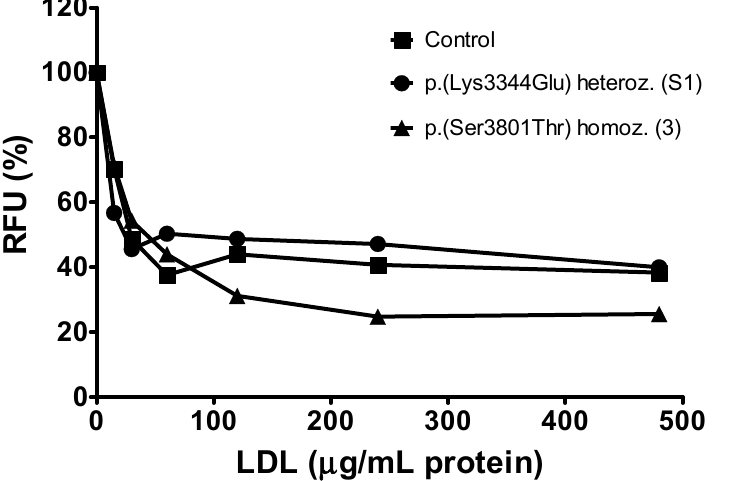
Figure 4. Competitive uptake of LDL by THP-1 macrophages. Ability of LDL from apoB p.(Lys3344Glu) heterozygous patient S1, the apoB p.(Ser3801Thr) homozygous patient 3 and the control to compete with DiI-LDL for cellular uptake ( p = 0.420). Results are expressed as percentage of DiI-LDL uptake in the absence of competitor LDL. The identification of each patient is indicated in brackets (see Table 1 and text). RFU, relative fluorescence units.